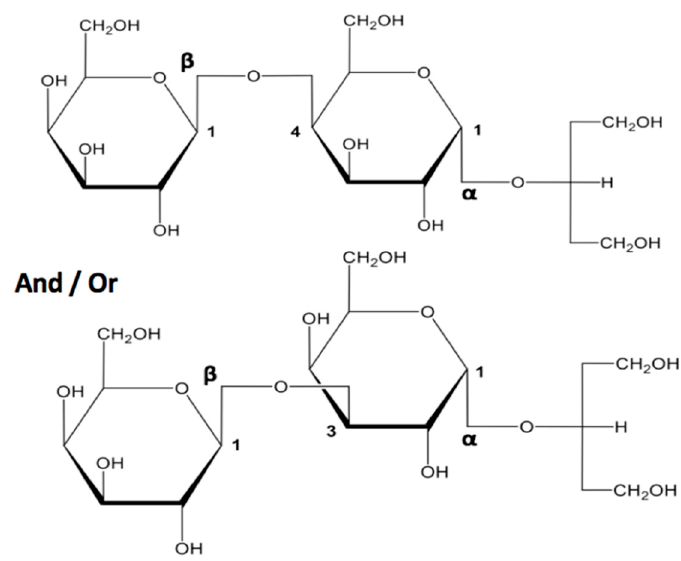
Figure 5. Structures of Gal 2 -Glycerol found in the alkaline extract of Gelidium sesquipedale .